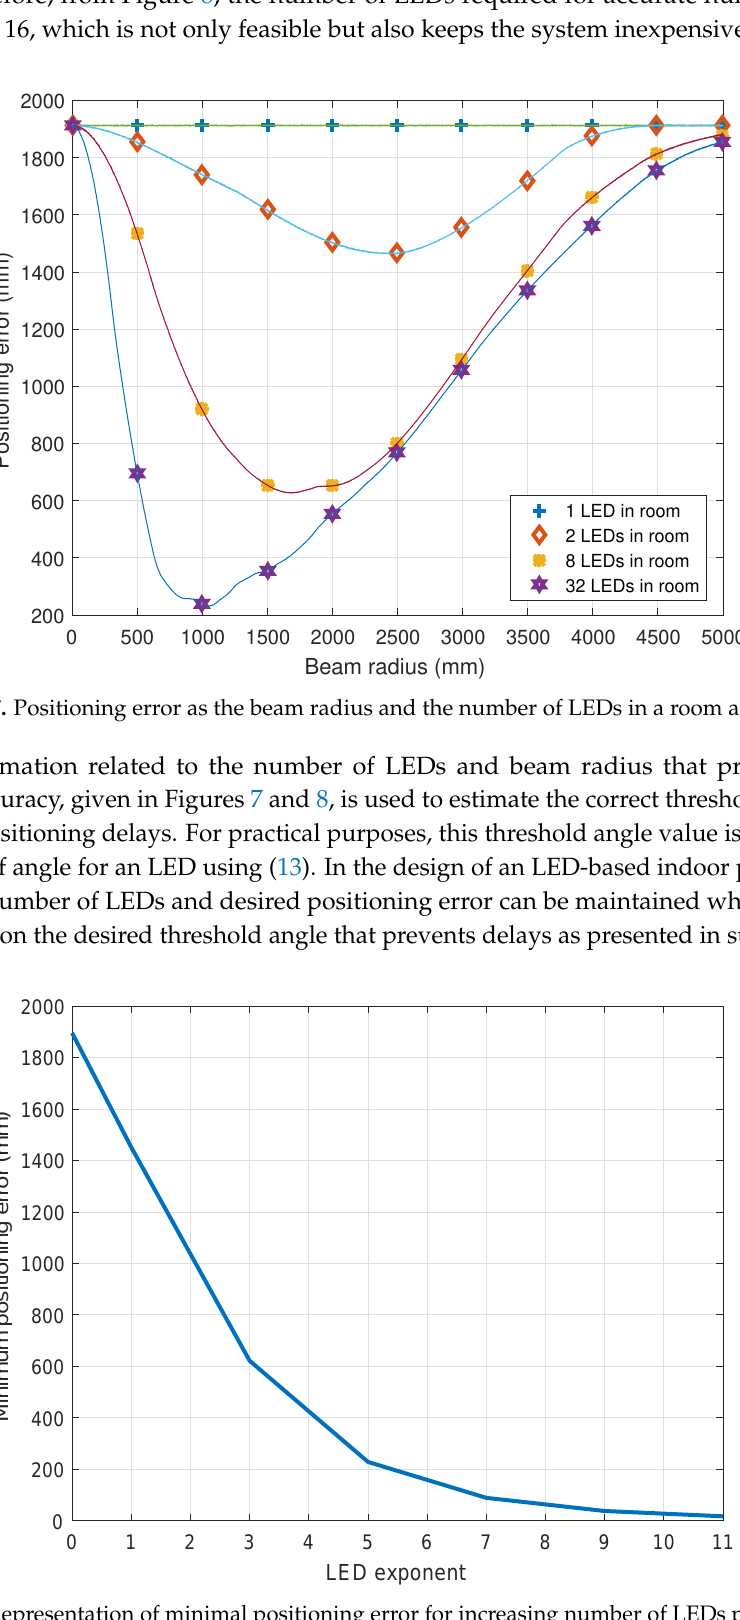
Figure 8. Representation of minimal positioning error for increasing number of LEDs presented as the LED exponent factor as defined in